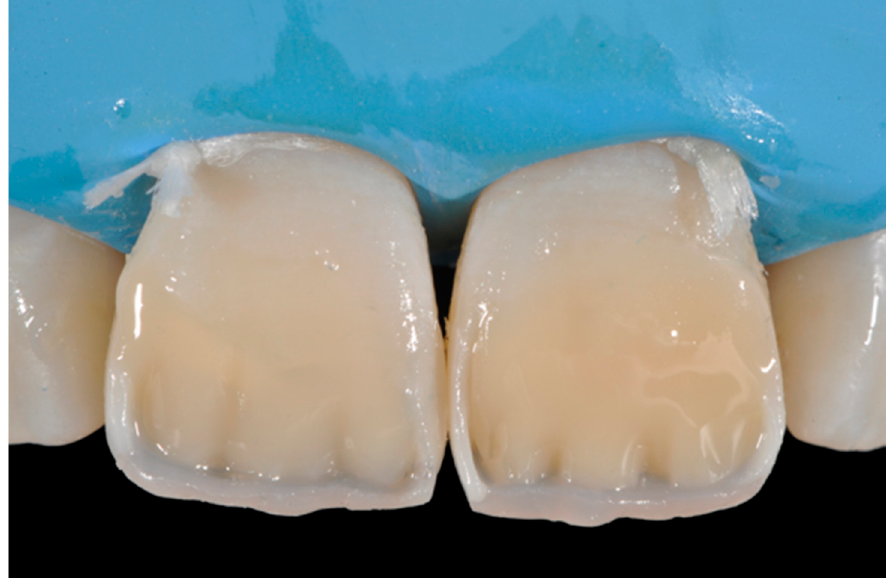
Figure 36. The dentinal body. Reprinted from Restauri diretti nei settori anteriori, G. Paolone, S. Scolavino, © 2021, with permission from Quintessence Publishing Italy.